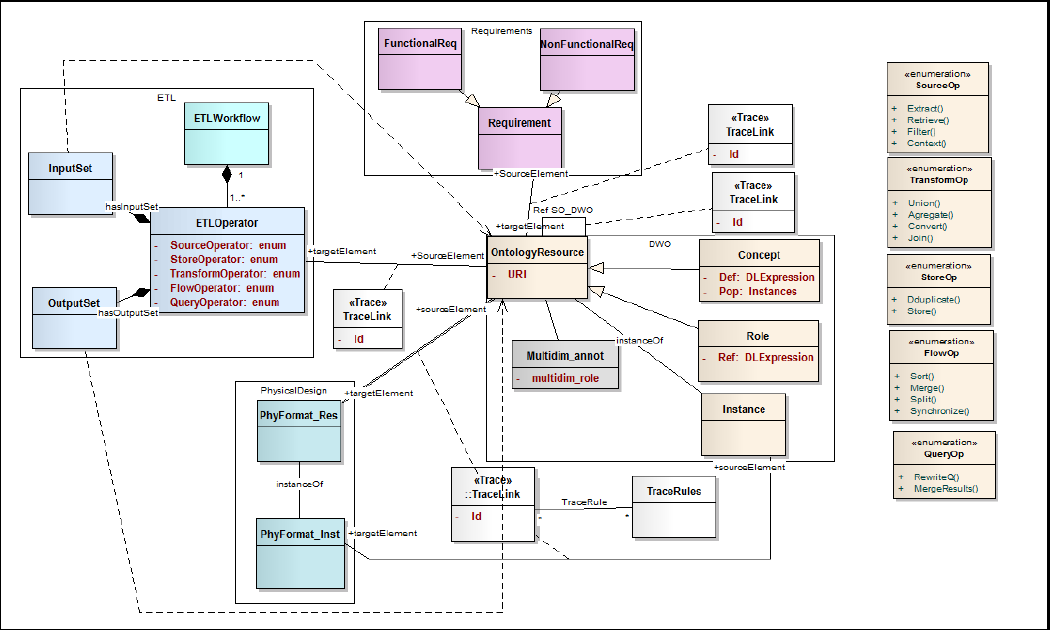
Figure 2. DW traceability model for managing